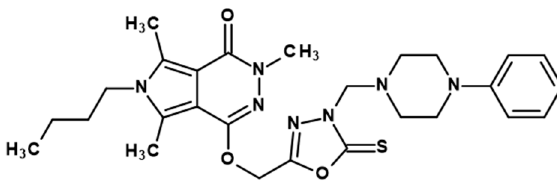
Figure 1. The structure of the most potent new Mannich base-type derivative of pyrrolo[3,4- d ]pyridazinone.